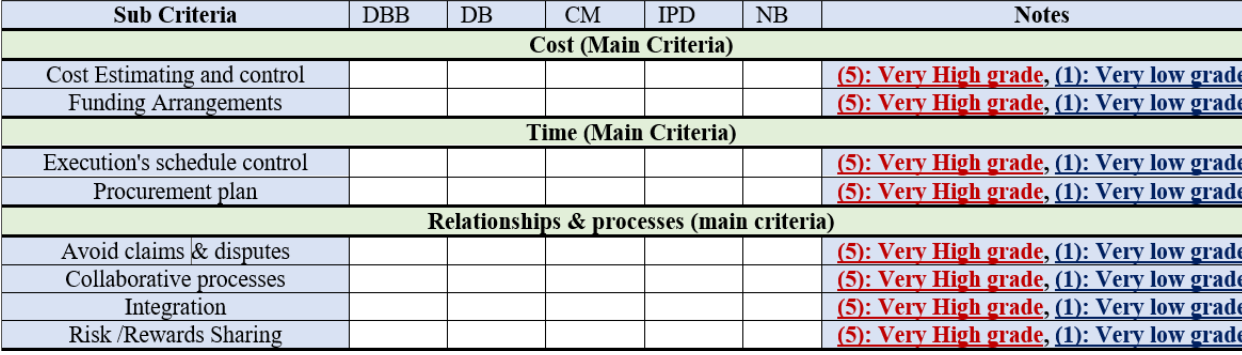
Figure 6. A sample of the assessment of different procurement methods included in the designed questionnaire.